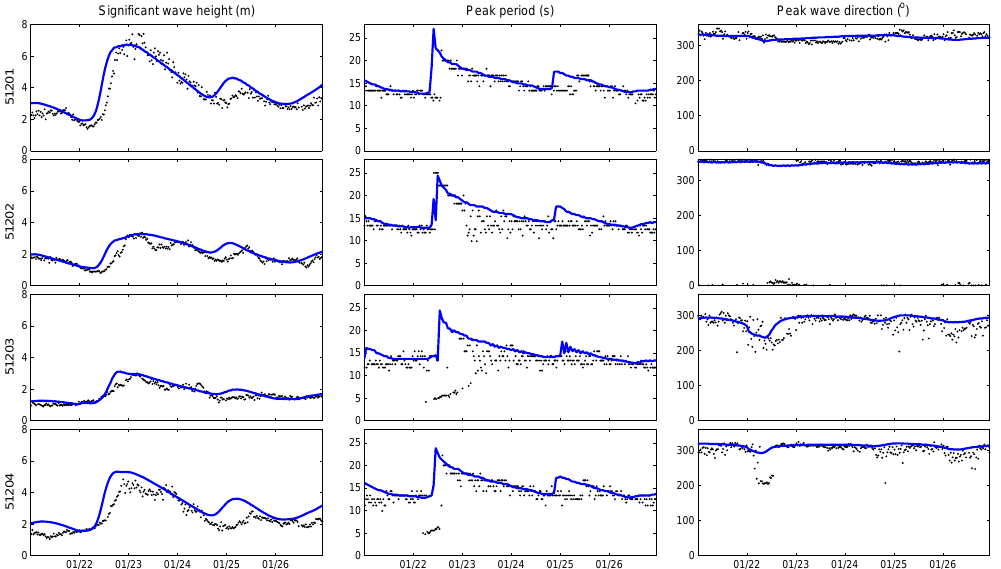
Figure 4. Comparison of the significant wave height, peak period, and direction between the NDBC buoys displayed in Fig. 1 and the wave model hindcast system results for the period of experiment 2. The black dots correspond to the buoy data and the blue line to the model